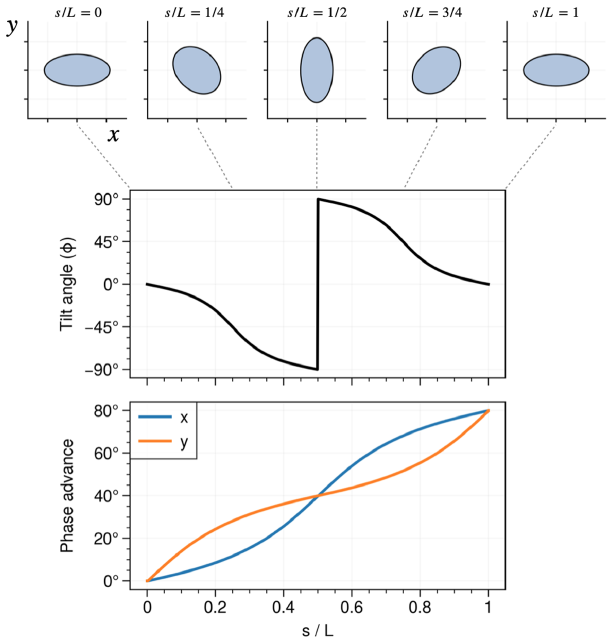
FIG. 2. Relationship between the tilt angle in real space and the x and y phase advances for a Danilov distribution in a FODO cell of length L . The beam is tracked without space charge by integrating the envelope